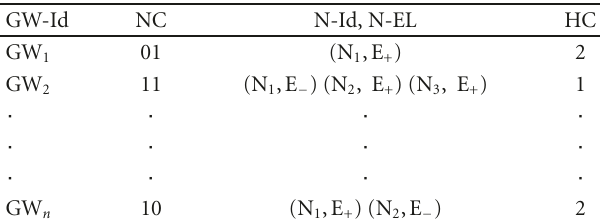
Table 1: Gateway